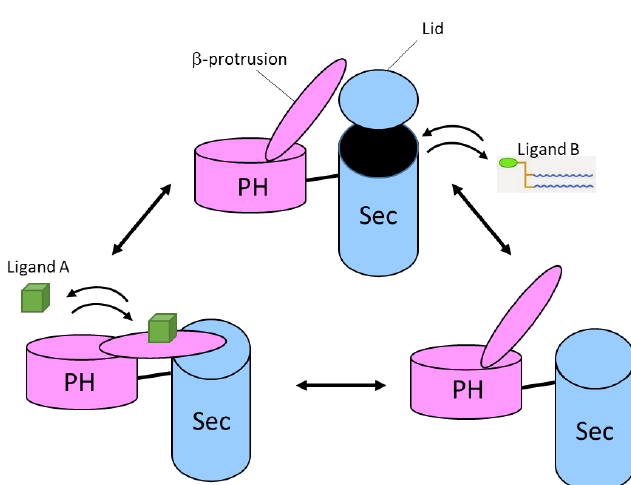
Figure 7. Proposed functional mechanism of the neurofibromin-SecPH module. Hypothetical mechanism of how conformational changes in the neurofibromin-PH domain upon binding of ligand A may regulate access to ligand B for the neurofibromin-Sec lipid-binding cage.